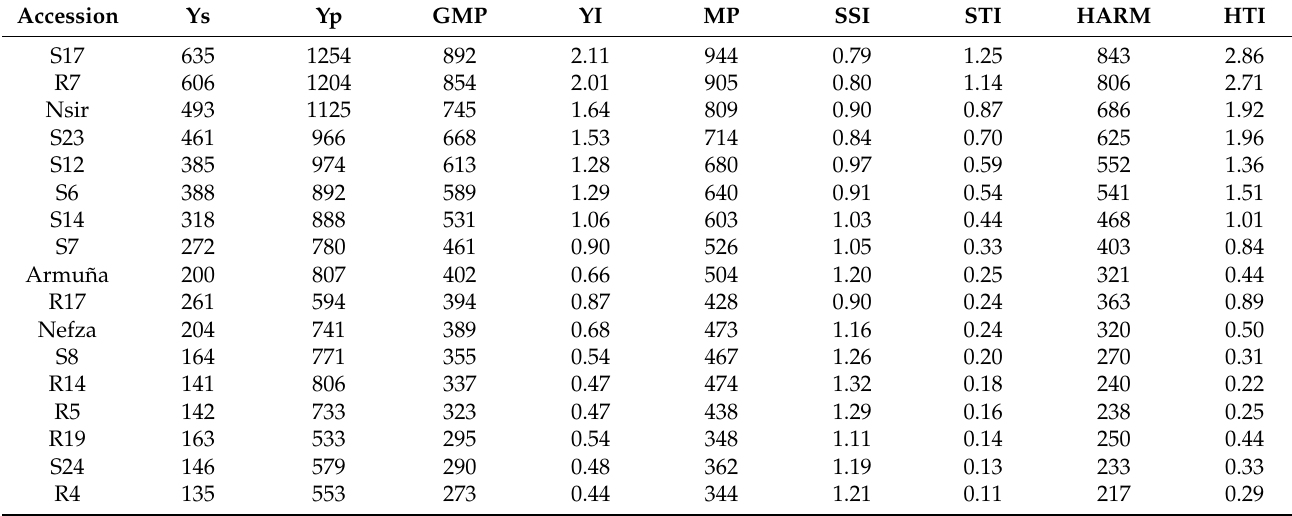
Table 9. Grain yield under stress and non-stress environments, and heat stress tolerance indices of the studied